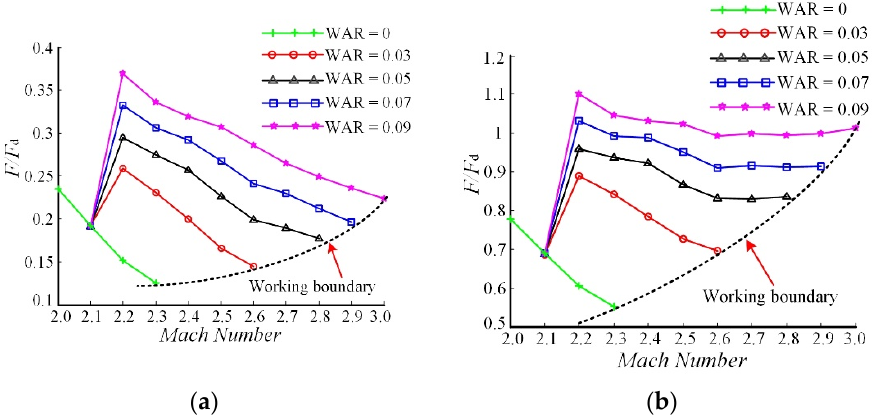
Figure 18. The thrust variation of the WIPCC engine ( a ) without afterburning, ( b ) with afterburning.